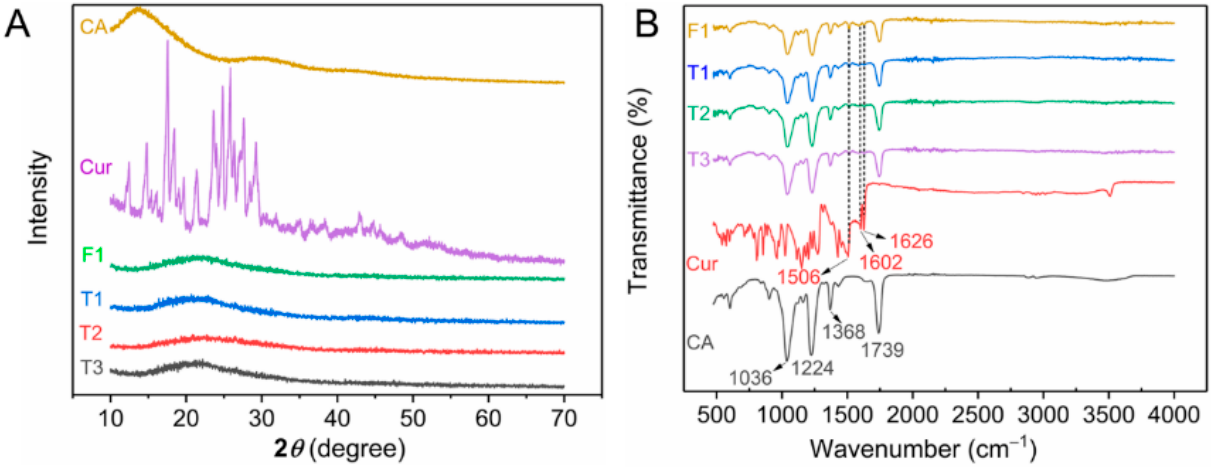
Figure 4. XRD pattern ( A ) and ATR–FTIR spectra ( B ) of raw materials (CA and curcumin powders) and prepared four fibers.